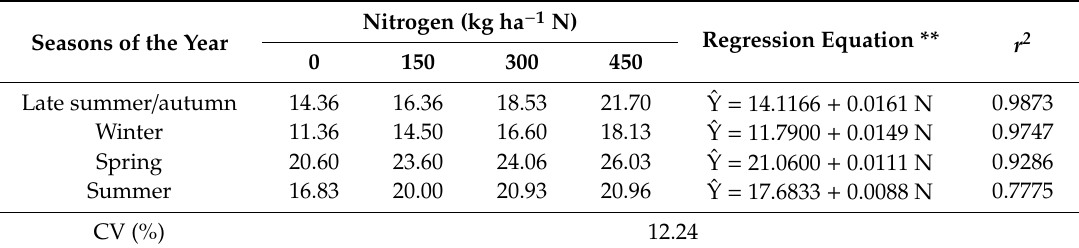
Table 10. Percentage averages of leaf blade in post-grazing forage mass of Brachiaria brizantha cv. Piat ã subjected to nitrogen fertilization throughout seasons of the year.